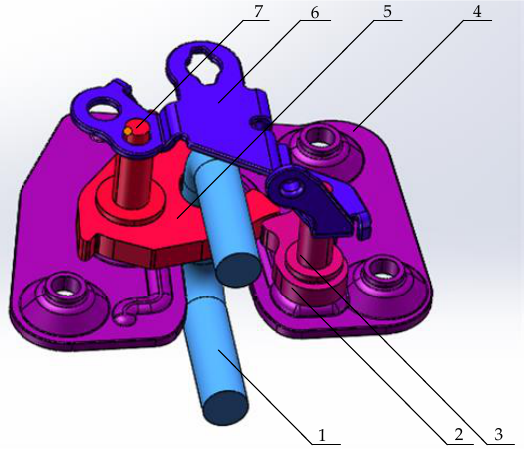
Figure 2. The holding mechanism model. (1) Striker, (2) pawl, (3) pawl riveting shaft, (4) bottom plate, (5) fork-bolt, (6) auxiliary bottom plate, (7) fork-bolt riveting shaft.